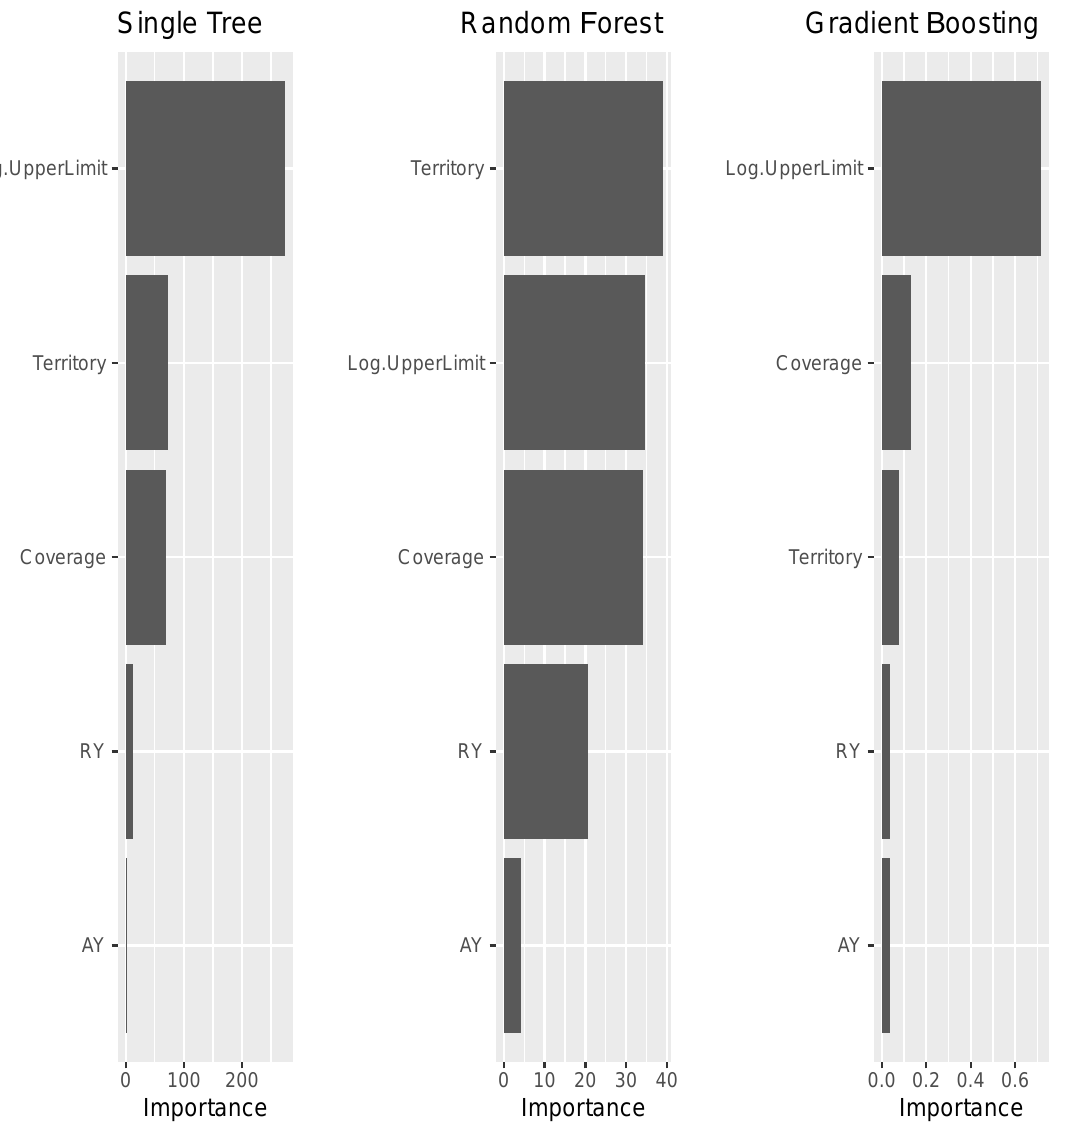
Figure 4. Variable importance measured by tree-based methods using log scale loss amounts as model response